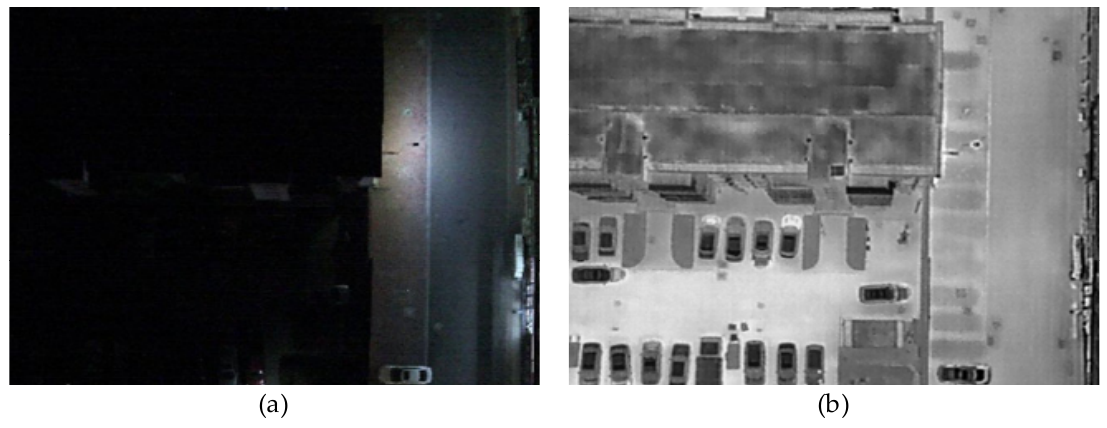
Figure 1. UAV images are acquired by visible light camera and infrared camera, respectively. ( a ) Visible image. ( b ) Infrared image.